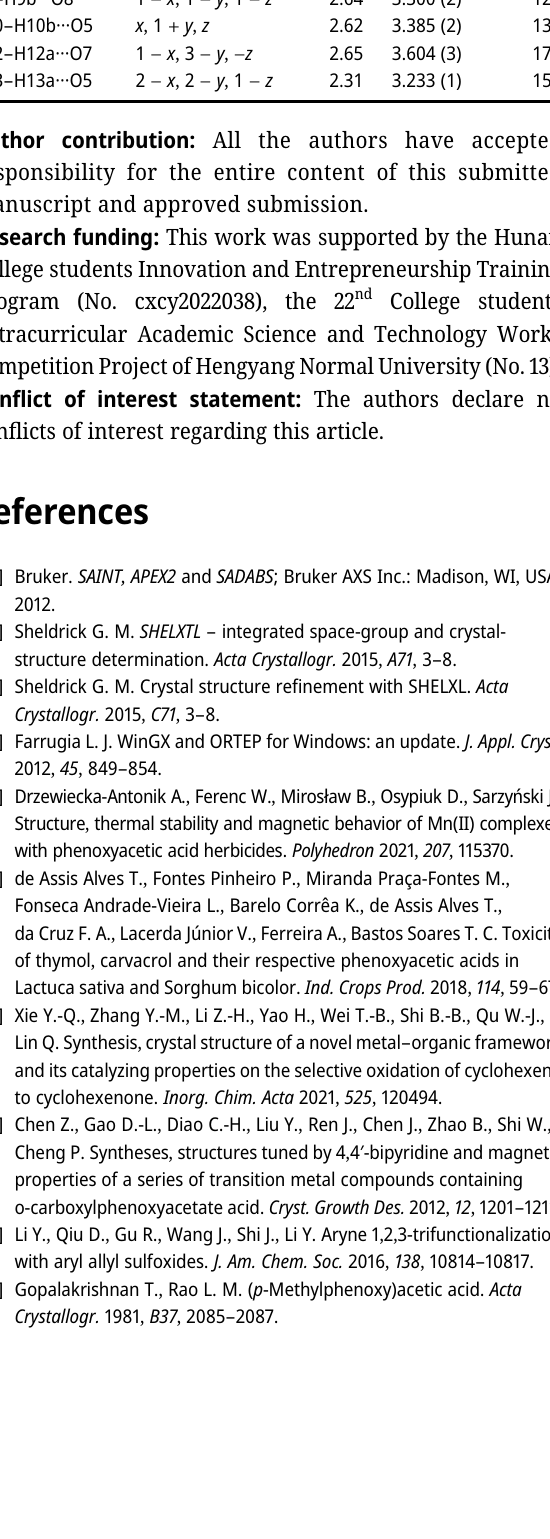
(Table 3). The geometric characteristics of these hydrogen bonds are close that does not allow to separate out a main structural motif of the crystal packing.